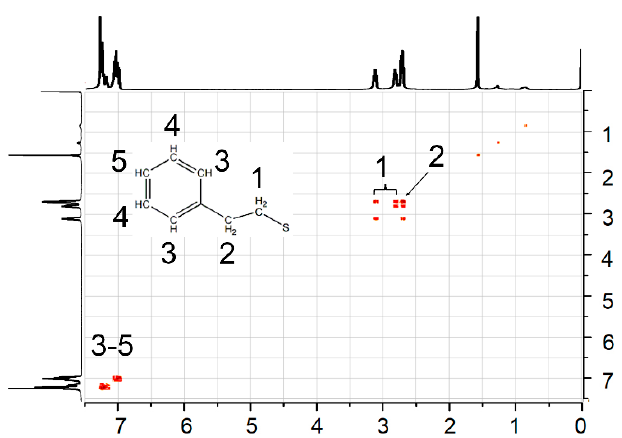
Figure 1. 2D COSY spectra of Pd 8 (PET) 16 nanoclusters ( room temperature, CDCl 3 as solvent).